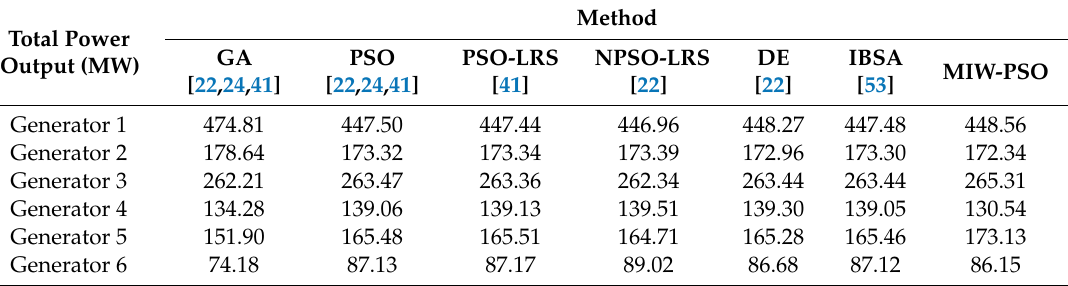
Table 8. Comparison of generator power output on the third case study.